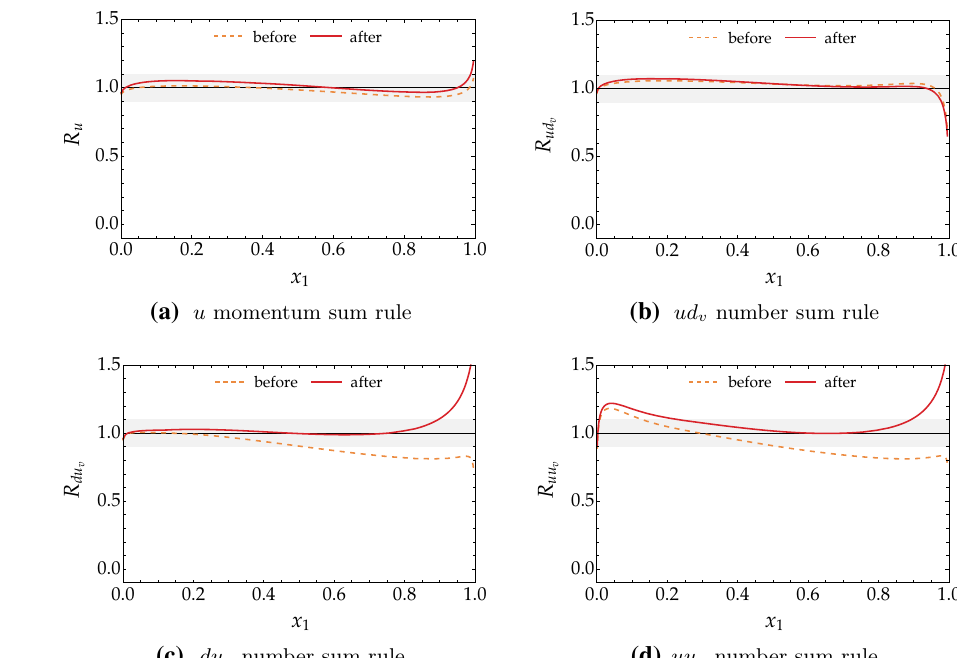
Fig. 7 Sum rule ratios in the first and second interactions of the model, which respectively correspond to the powers (23) and (25) in the phase space factor R u